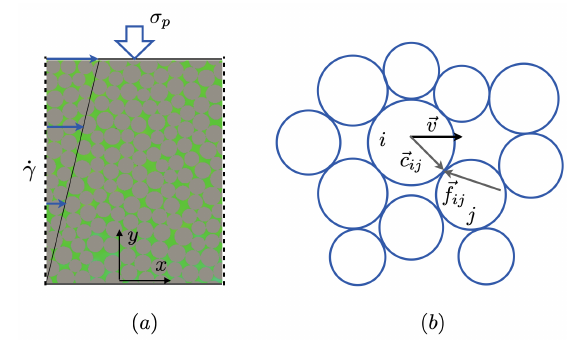
Figure 1. (a) Simple shear geometry; (b) Local particle environ-